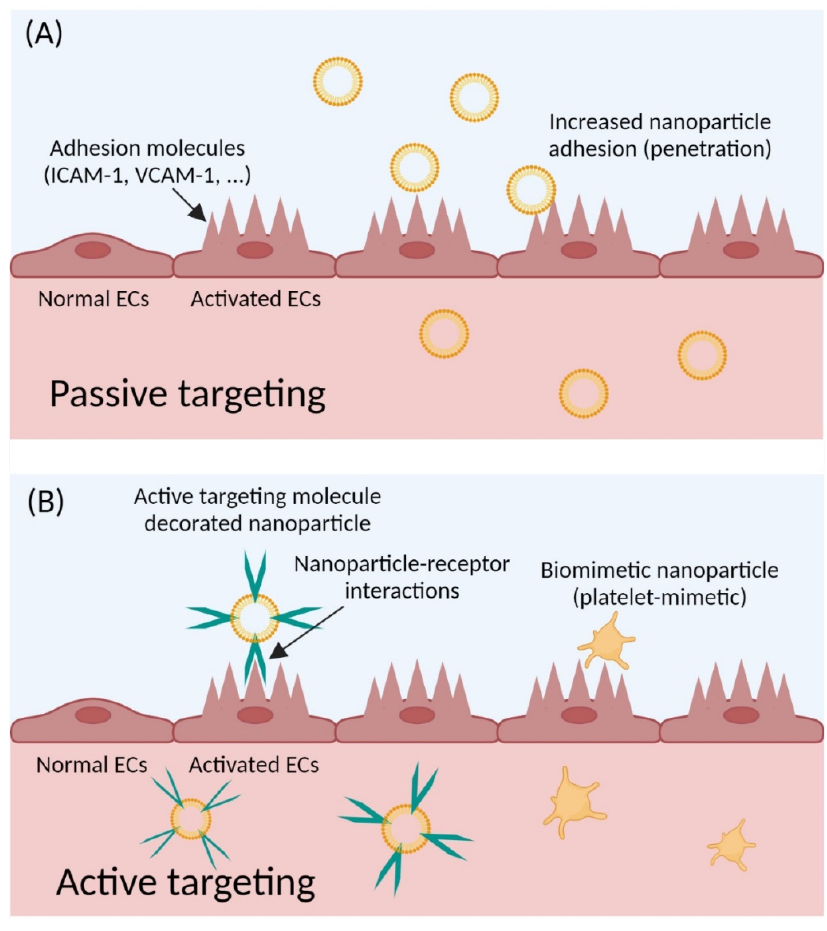
Figure 4. Targeted delivery of NPs. ( A ) Passive targeting is accomplished by increased nanoparticle adhesion to the adhesion molecules of activated endothelial cells, and ( B ) the active targeting method needs targeting molecule-decorated nanoparticle and biomimetic